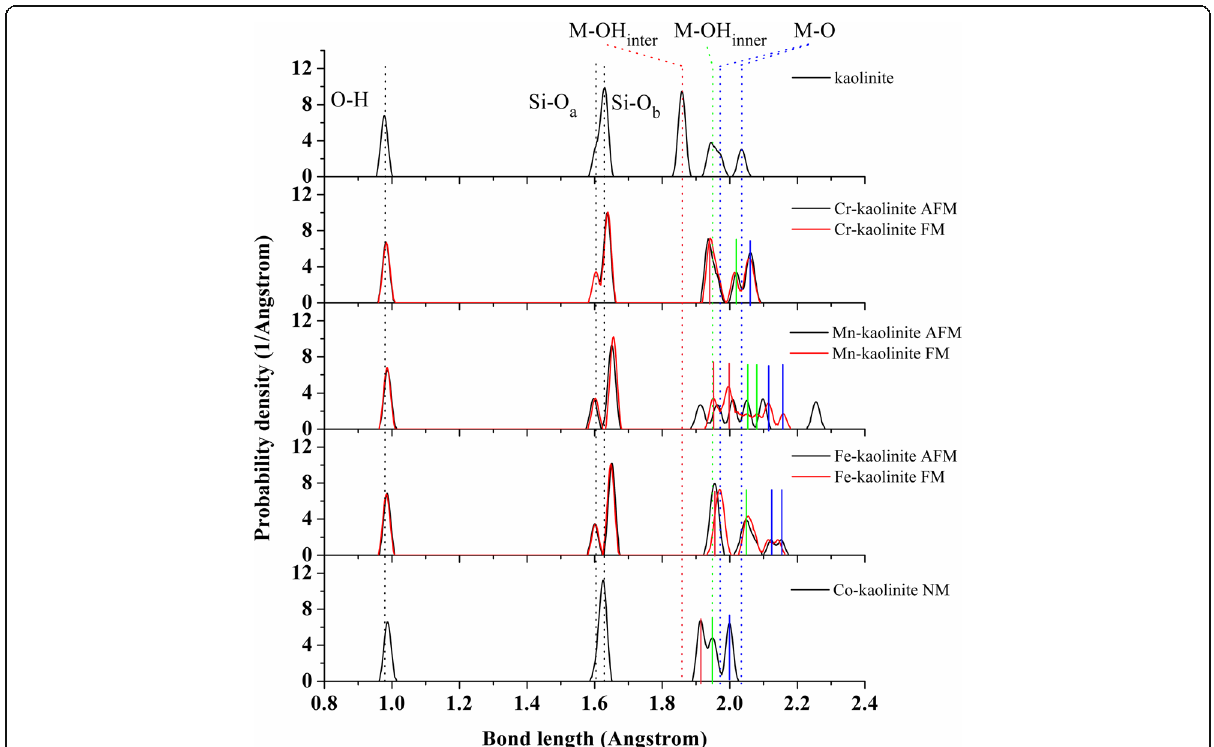
Fig. 2 The bond distribution of Cr – , Mn – , Fe – , and Co – kaolinite. Multi-magnetic states are given for each TM – kaolinite. The averaged different types of O – H ( black ), Si – O a ( black ), Si – O b ( black ), M – OH inter ( red ), M – OH inner ( green ), and M – O ( blue ) bonds in kaolinite are indicated by dot lines . The M – OH inter ( red ), M – OH inner ( green ), and M – O ( blue ) bonds in Cr – kaolinite ( AFM ), Mn – kaolinite ( FM ), Fe – kaolinite ( AFM ), and Co – kaolinite ( NM ) are indicated by solid